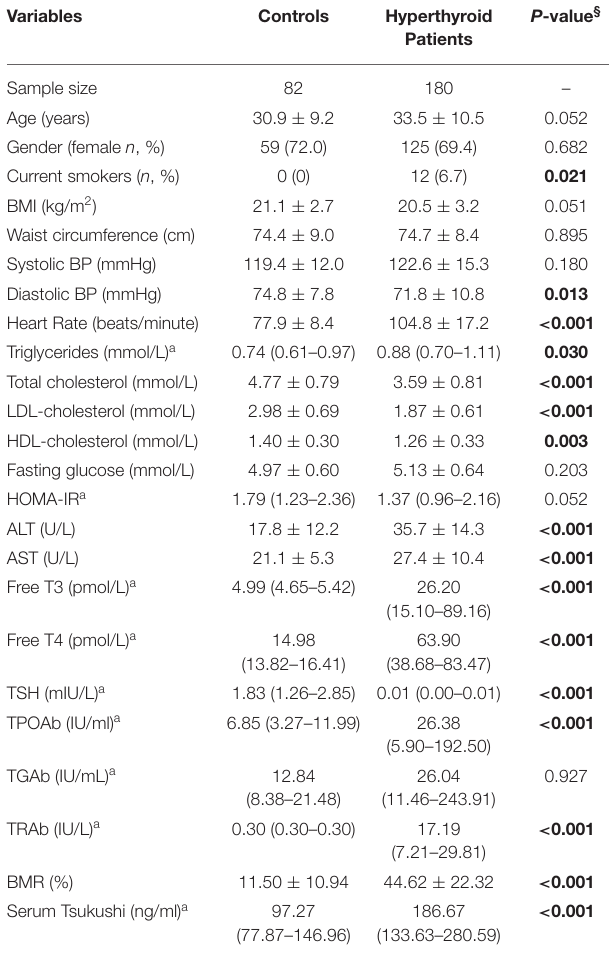
TABLE 1 | Clinical characteristics of hyperthyroid patients and